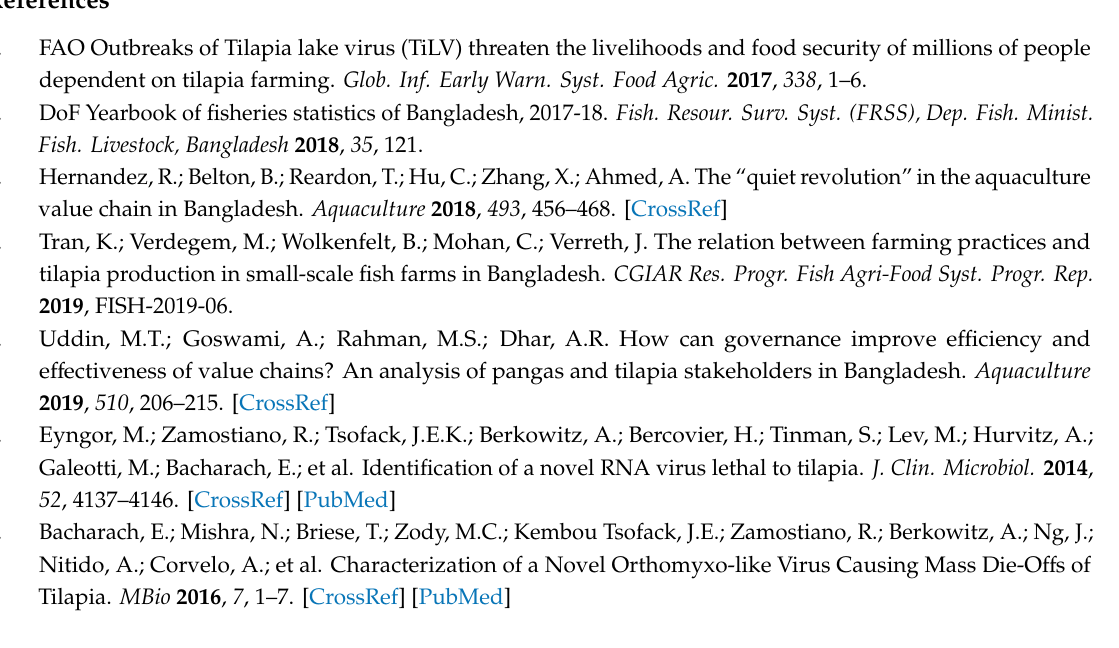
Figure S1: Diseased tilapia from a ff ected pond, Figure S2: Detection of amplicons consistent with TiLV in tilapia tissues from a ff ected pond, Figure S3: Necrosis of pancreatic acinar cells and accompanying inflammation (pancreatitis), Figure S4: Extensive loss of normal liver tissue architecture, Figure S5: Eosinophilic cytoplasmic inclusion bodies within hepatocytes, Figure S6: Large multinucleated syncytia, Figure S7: Absence of detectable TiLV amplicons in common carp, rohu and pangasius tissues from the a ff ected pond, Figure S8: Maximum likelihood phylogenetic trees based on amino acid sequence alignments of all ten segments, Figure S9: Bootstrap values of neighbour-joining trees constructed from 35 quartets of TiLV isolates, Table S1: Physical / chemical parameters of a ff ected pond water, Table S2: Fish sampled from a ff ected pond in Trishal Upazila, Bangladesh, Table S3: Primers used in semi-nested RT-PCR assay for TiLV, and Table S4: Primers used to amplify a fragment of each TiLV segment. Supplementary data 1: QualiMap output file from assembly of TiLV genome BD-2017. Supplementary data 2: Partial segment nucleotide alignments for segments 1, 2, 3, 4 and 9, used to generate the maximum likelihood phylogenetic trees in Figure 3. Supplementary data 3: Full segment nucleotide alignments for all ten segments, used to generate the maximum likelihood phylogenetic trees in Figure 4. Supplementary data 4: Output of quartet